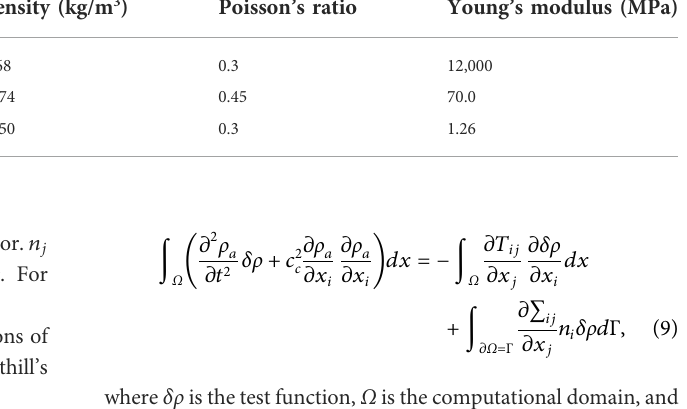
Harvested sigmoid plate